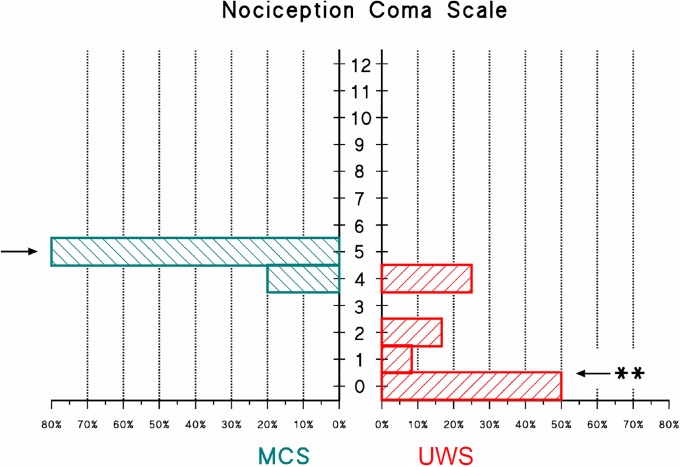
Frequency distribution of NCS scores.Frequency distribution is shown for the MCS (left histogram) and UWS (right histogram) groups; the arrows show the median values of each distribution; the “**” indicates a statistically significant difference between distributions at p<0.01 (Mann Whitney U test).